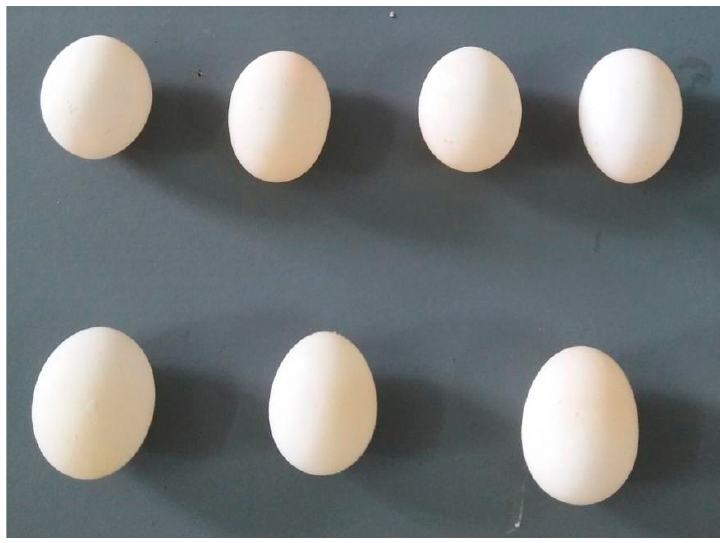
Figure 4. Eggs of the white-rumped munia ( Lonchura striata ) used in this study. Three nest boxes of a nest box sample site were randomly placed separately in DLS and QCF: a brownish gray cloth (10 cm) was added to the nest boxes (the experimental group EC), 10 cm of snake sloughs was added to the nest boxes (the experimental group E), and no treatment was applied to the nest boxes (the control group C). Three treatments were randomly placed correspondingly in three nest boxes of a nest box sample site in HNU: 10 cm of snake slough was added to the nest boxes (the experimental group E), 10 cm of snake sloughs was suspended at the mouth of the nest boxes (the experimental group ES), and no treatment was applied to the nest boxes (the control group C). As the results of Liu and Liang (2021a) found that there was no significant difference in predation rate between the group with cloth boxes added and the group without treatment [12], HNU boxes therefore did not have the brown cloth in the nests. The experimental group ES in HNU was added to examine visual cues for snake